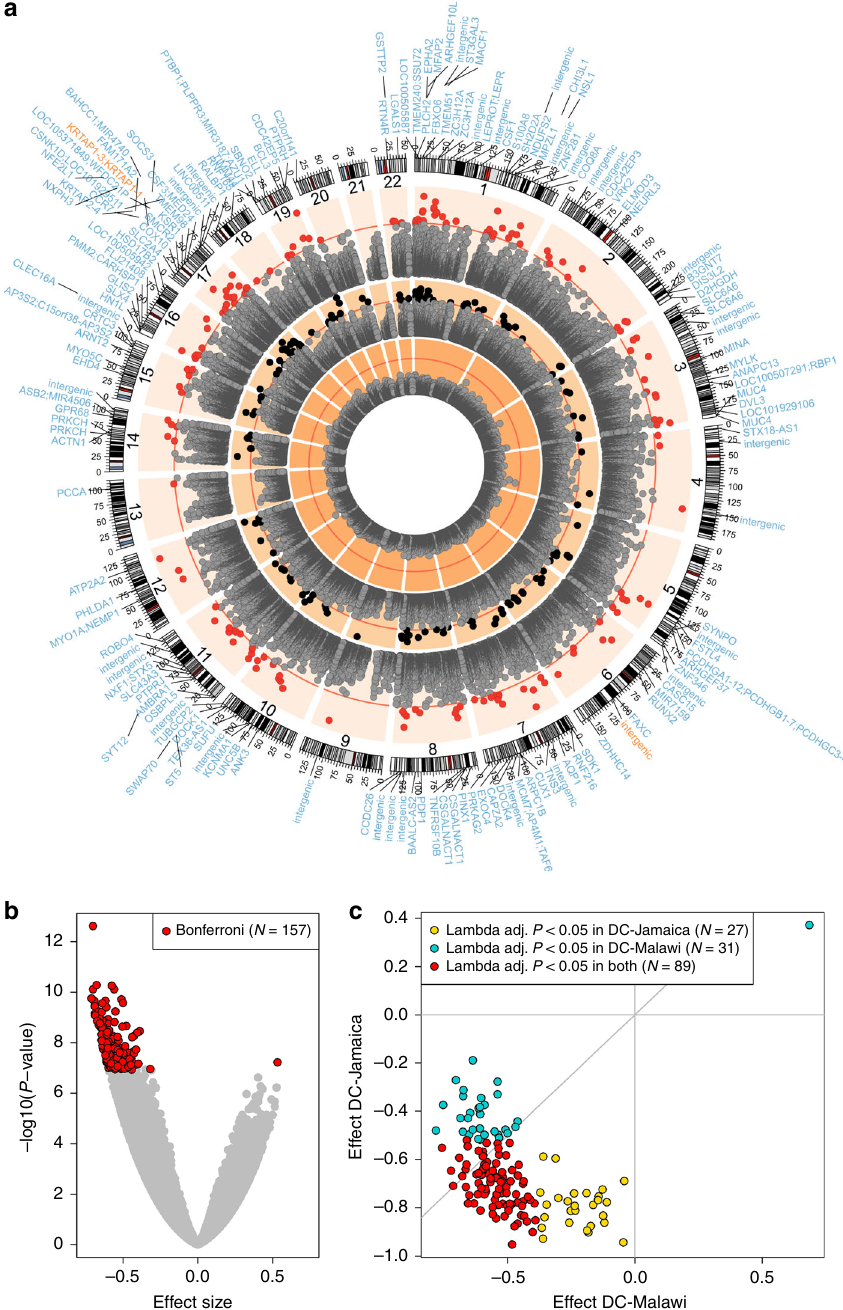
Fig. 2 DNA hypomethylation in ESAM. a The genome position of each locus is plotted against its − log 10 ( P value). Depicted, from the inner to the outermost ring, are the recovered (DL) single site, acute (DC) single site, and DC cluster-based differential methylation results. Red lines mark the Bonferroni threshold of signi fi cance for each analysis. Black ( N = 157) and red dots ( N = 166) pass this signi fi cance threshold, in their respective analyses. Gene symbols around the plot perimeter represent the gene(s) within 10 kb of the signi fi cantly differentially methylated clusters (outer ring). Gene symbols in blue are hypomethylated in ESAM, gene symbols in orange are hypermethylated. b Volcano plot of effect sizes among all DC single sites. c Concordance of effect size and adjusted statistical signi fi cance between Jamaica and Malawi DC samples at the N = 157 Bonferroni-signi fi cant single CpG sites; ten sites were found to be age-sensitive in each of the country-speci fi c analyses and were omitted (Methods). All P values are based on t test results from regression